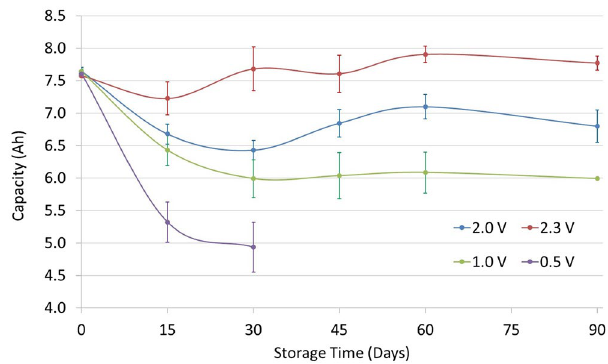
Figure 2. Capacity fade with storage duration at different